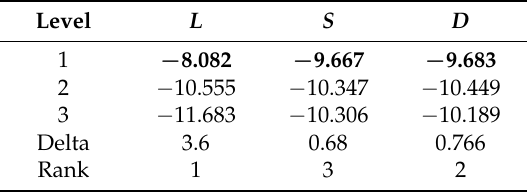
Table 6. Response table for S/N ratios of W s .